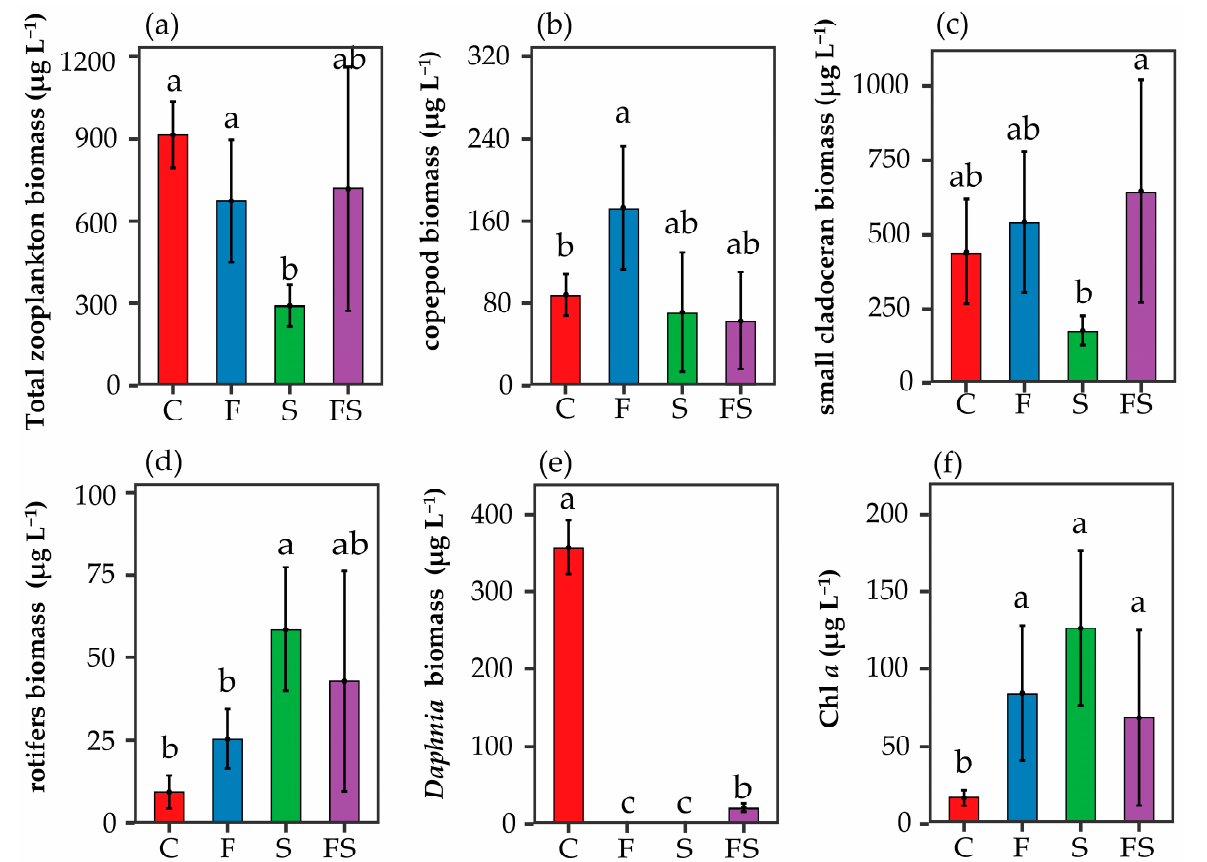
Figure 2. Trophic level changes under different predator scenarios. ( a ) Total zooplankton biomass, ( b ) copepod biomass, ( c ) small cladoceran biomass, ( d ) rotifers biomass, ( e ) Daphnia biomass, ( f ) chlorophyll a concentration. C: Control, F: Fish-added treatment, S: Shrimp-added treatment, FS: Fish–shrimp-added treatment. Values represent the mean ± SE (n = 6). Different letters above the bars indicate significant differences based on the results of one-way ANOVA.